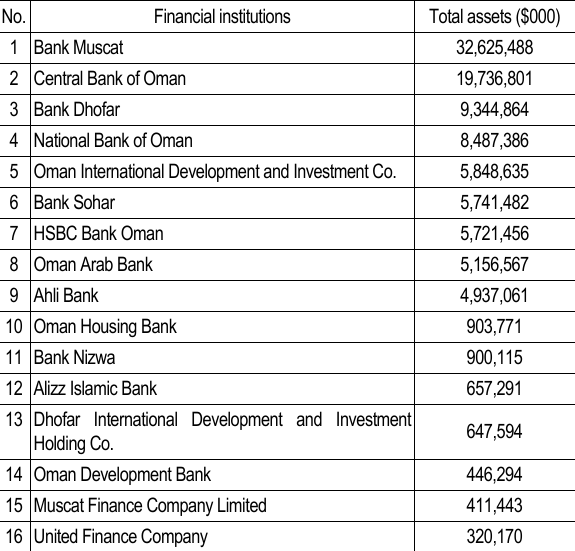
Table 1. Total assets of financial institutions in Oman